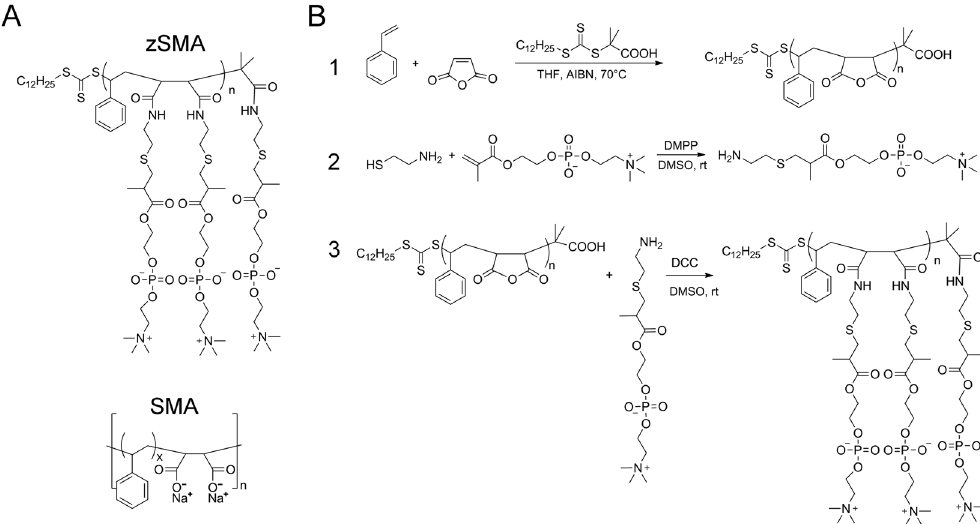
Figure 1. New family of zSMA copolymers. ( A ) Structures of the zSMA copolymers prepared by RAFT polymerization (top) compared with conventional SMA (bottom). The letter n signifies the number of repeating units. In the most frequently used commercial copolymers x ~3. ( B ) Reaction scheme for the synthesis of